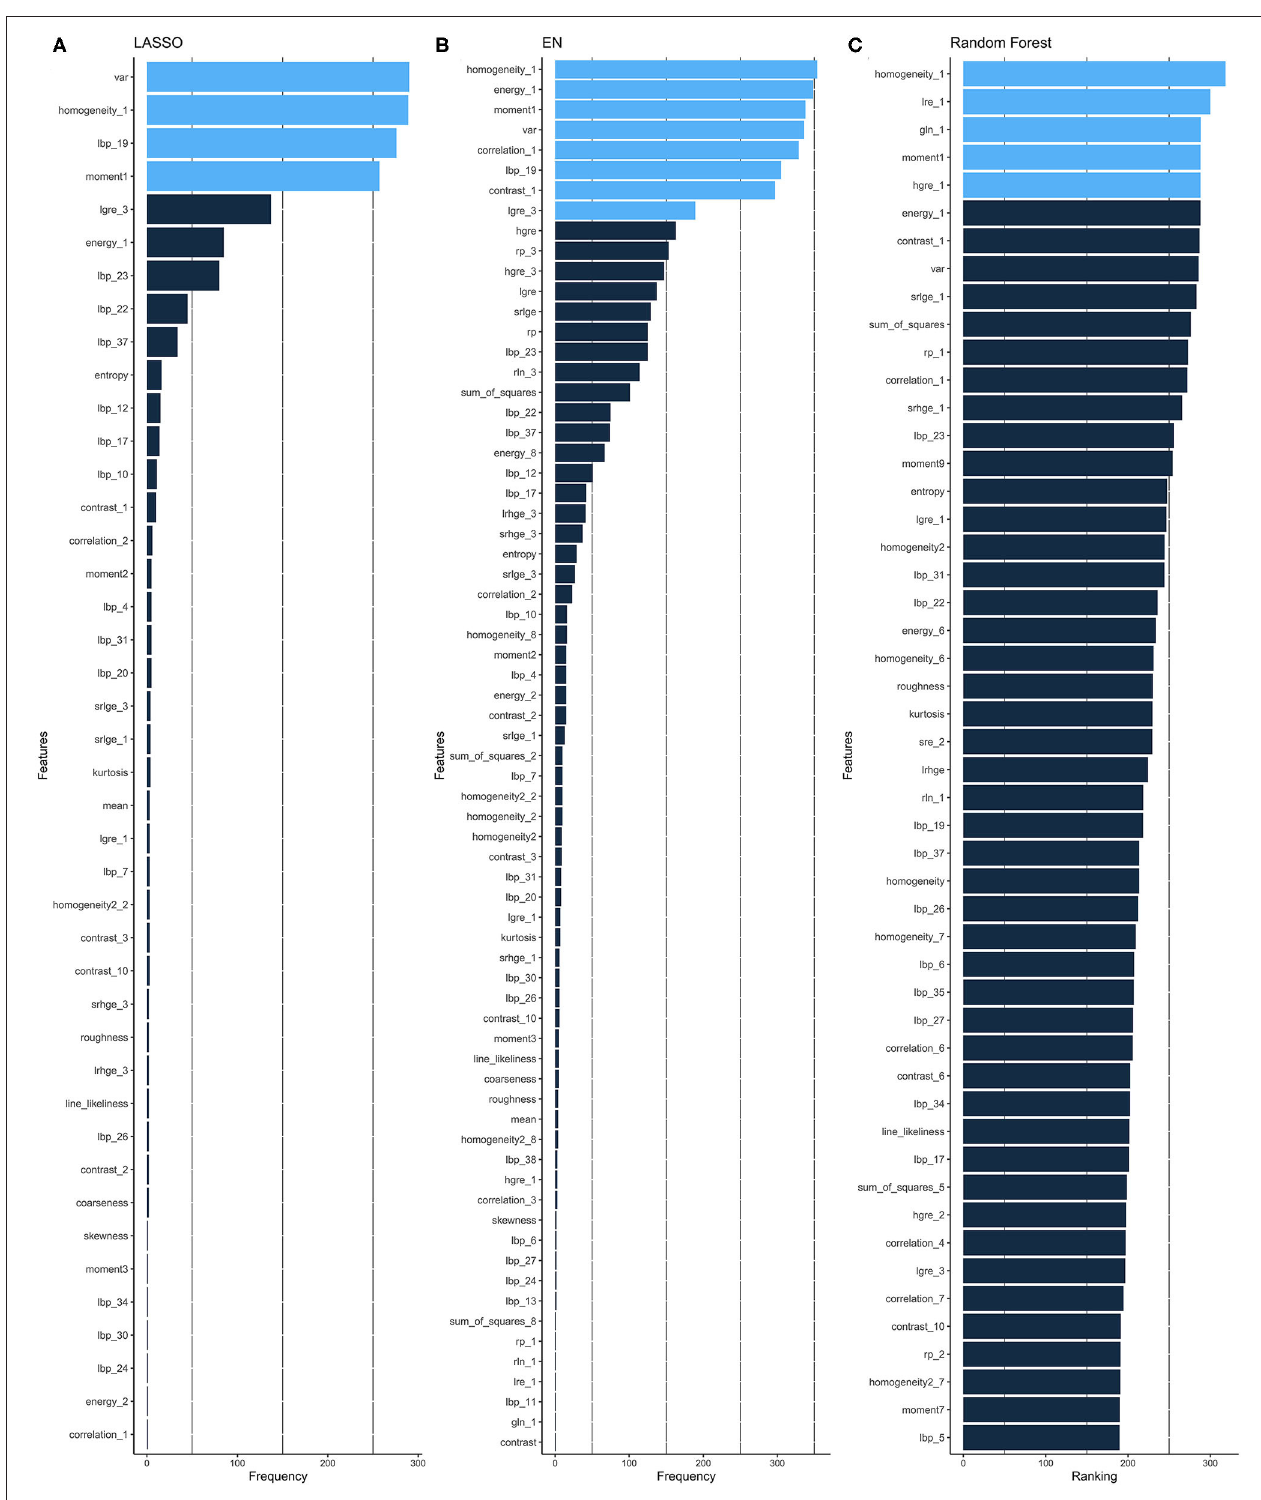
FIGURE 2 | Feature selection. Ranking of important features of CoxNet with alpha = 1 i.e., LASSO (A) and alpha = 0.5 i.e., EN, (B) and Random Forest (C) algorithms. The features selected can be seen in light blue and are those that have appeared above a particular threshold of times. EN, elastic net; LASSO, Least Absolute Shrinkage and Selection